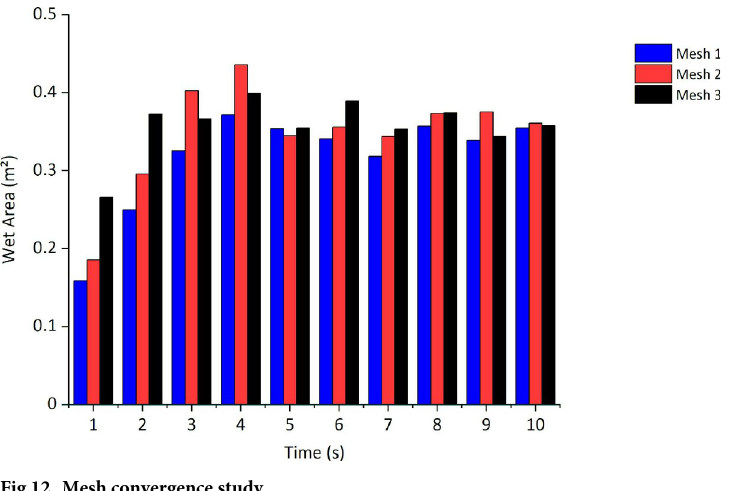
Fig 12. Mesh convergence